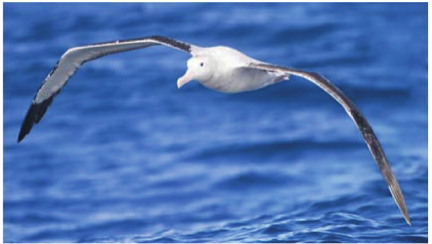
Figure 1: Wing roll articulation during bird flight.